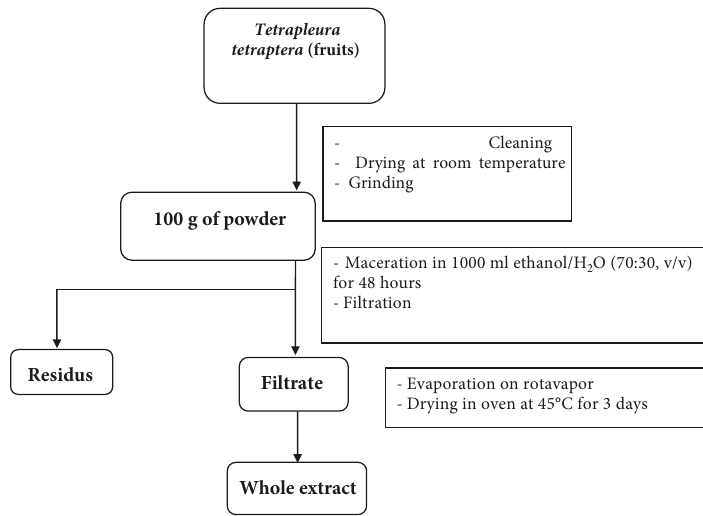
Figure 1: Extraction procedure of the crude